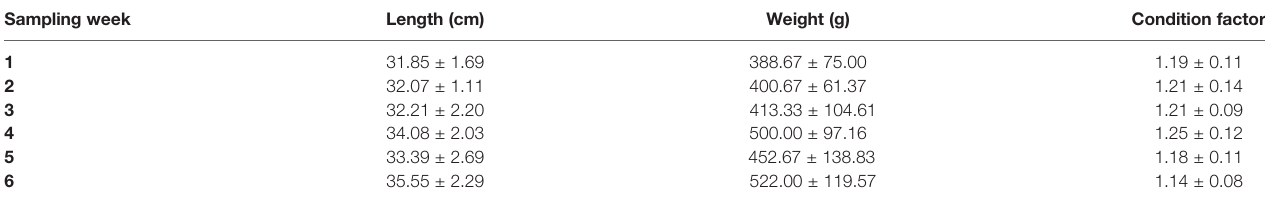
TABLE 2 | Mean (± SD, N = 15) length, weight and K factor at sampling day. Sampling week Length